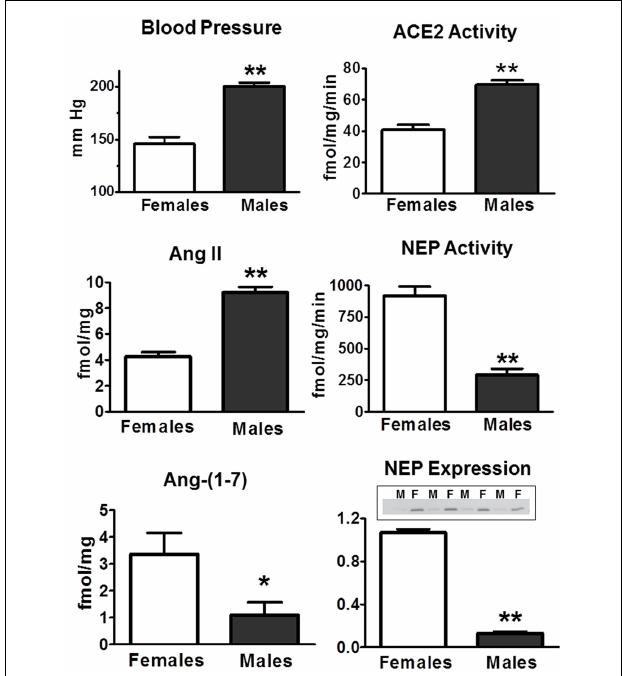
FIGURE 5 | Sex differences in systolic blood pressure and RAS components in the renal cortex of 15-week-old hemizygous mRen2.Lewis congenic rats . Systolic blood pressure (mmHg) is higher in males. Intrarenal concentrations (femtomole peptide per milligram protein – fmol/mg) of Ang II are higher in males, but Ang-(1–7) content is lower. ACE2 activity (femtomole product per milligram protein per minute – fmol/mg/min) is higher in males, but neprilysin (NEP) activity is lower in males. NEP expression assessed byWestern blot was lower in males (M) as compared to females (F). Data are mean ± SEM; n = 4–8 per group; * P < 0.05 or ** P < 0.01. Adapted from Pendergrass et al.